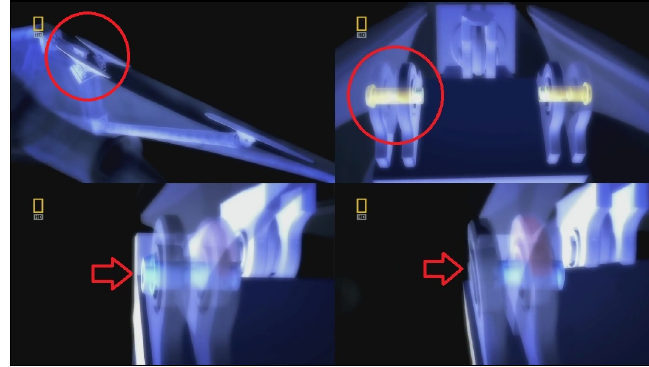
Figure 4 – Internal safety pin of the mid spar Рис . 4 – Внутренний предохранительный штифт среднего лонжерона Slika 4 – Unutrašna sigurnosna osovinica srednje ramenja č